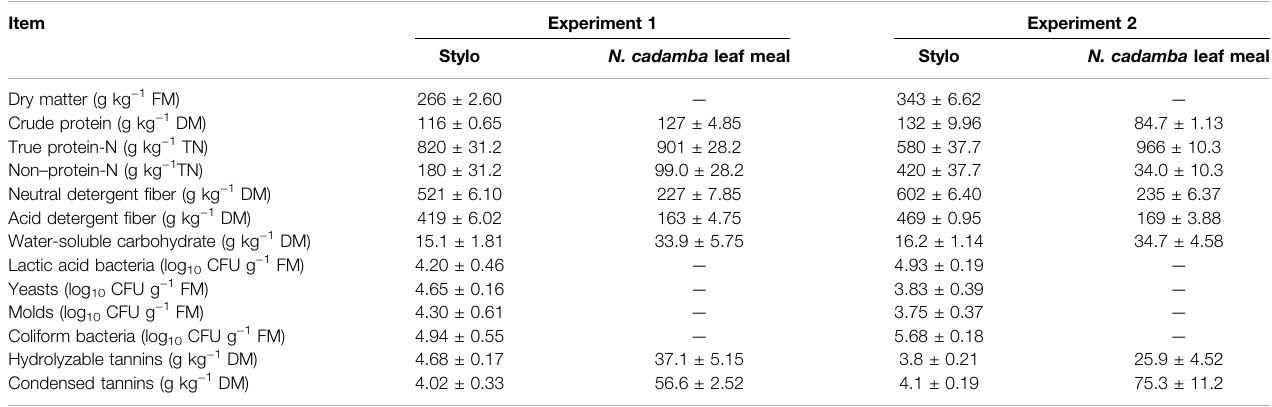
TABLE 1 | Characteristics of fresh stylo and N. cadamba leaf meal prior to ensiling (±SD, n = 3).